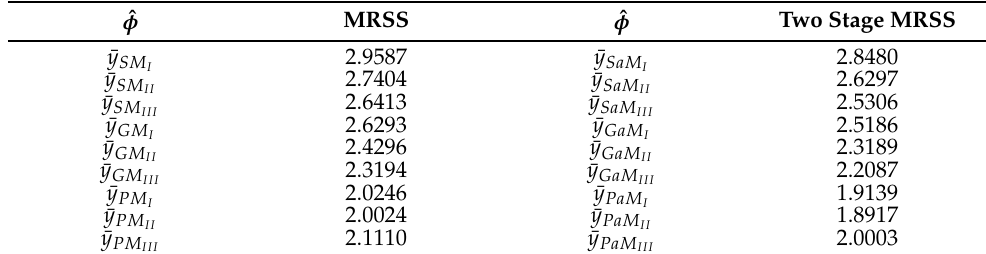
Table 10. Bias values of estimators for real-life